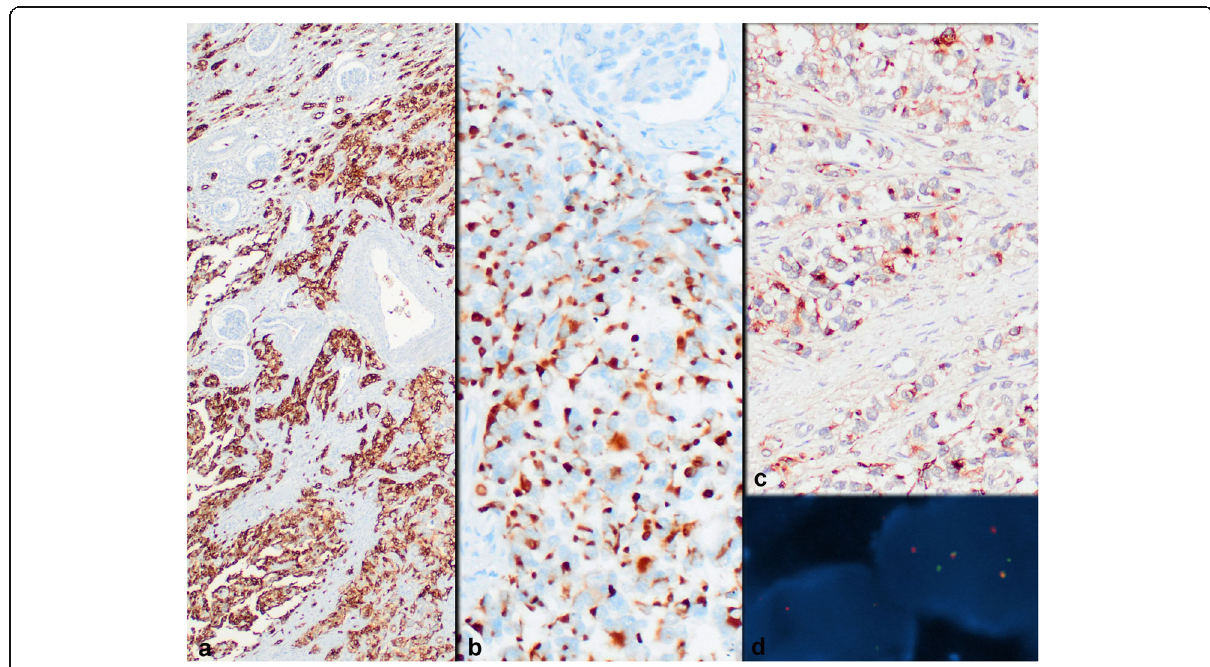
Fig. 5 Strong EMA ( a ), perinuclear dot-like desmin ( b ) and non-specific cytoplasmic (non-nuclear) WT1 expression ( c ) by neoplastic cells, ( d ) is FISH analysis showing ESWR1 rearrangement ( a Immunohistochemistry, anti-EMA Ab × 40; b Immunohistochemistry, anti-desmin Ab × 200; c Immunohistochemistry, anti-WT1 (N-terminal) Ab × 200; d Dual Color Break Apart specific locus FISH probe targeting EWSR1 gene at 22q12.2 chromosomal region; green and red signals mark the 5 ′ and 3 ′ ends of the gene